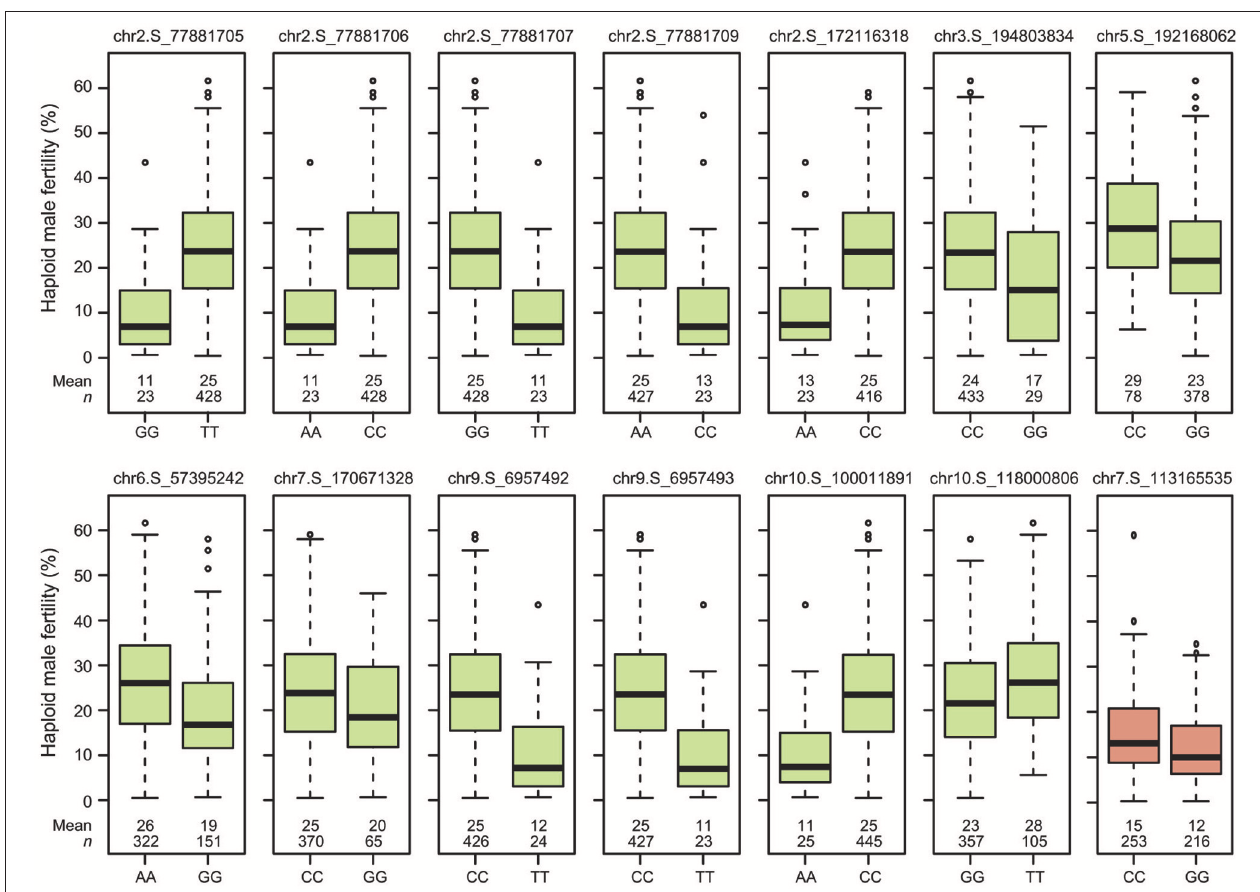
FIGURE 4 | Boxplots showing the effects of the QTL identified in the “Mo17” (green) and “Zheng58” (red) genetic backgrounds on haploid male